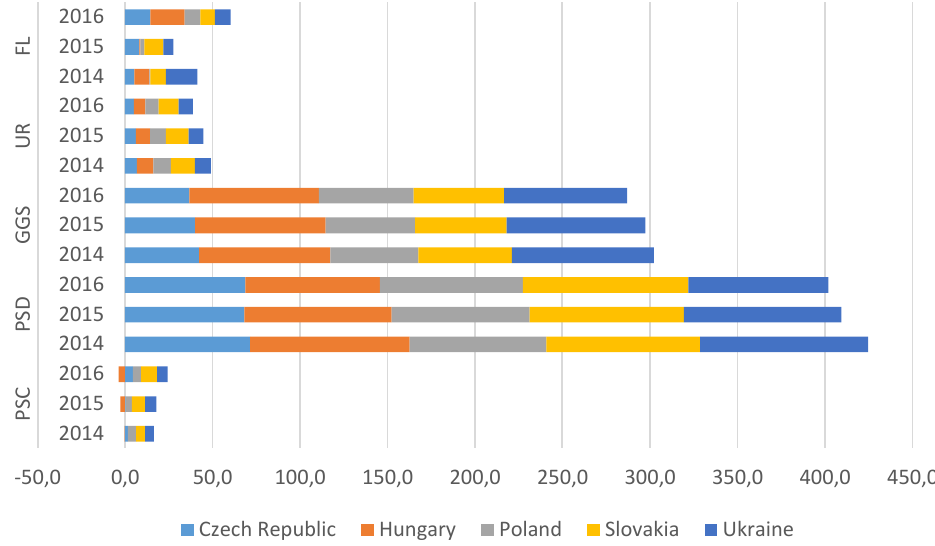
Figure 4. The internal indicator of MIP (excluding HP) of Visegrad Group and Ukraine in